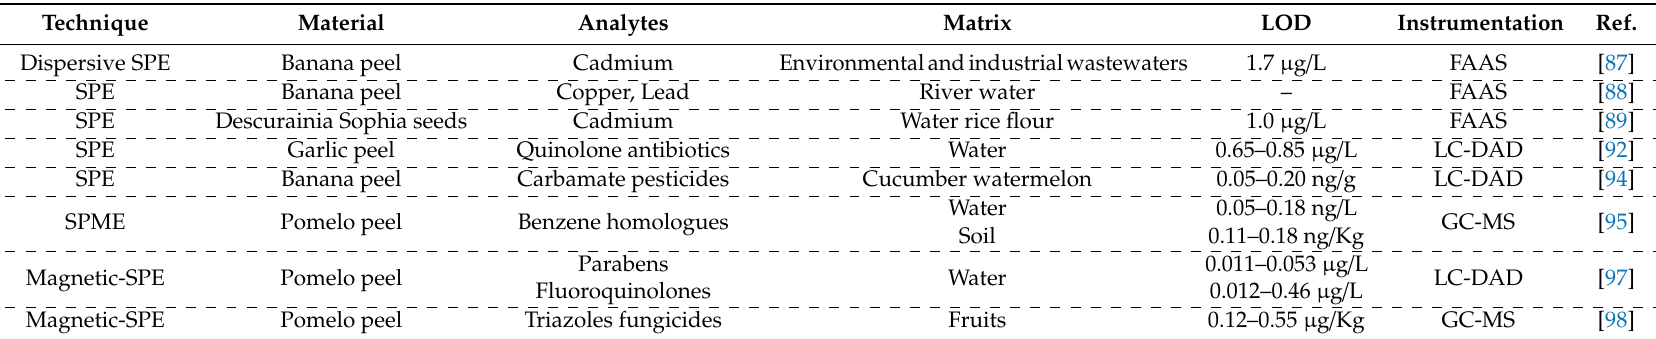
Table 4. Application of agricultural by-products as sorbent material in microextraction techniques for di ff erent analytes and matrices. (Reference period: